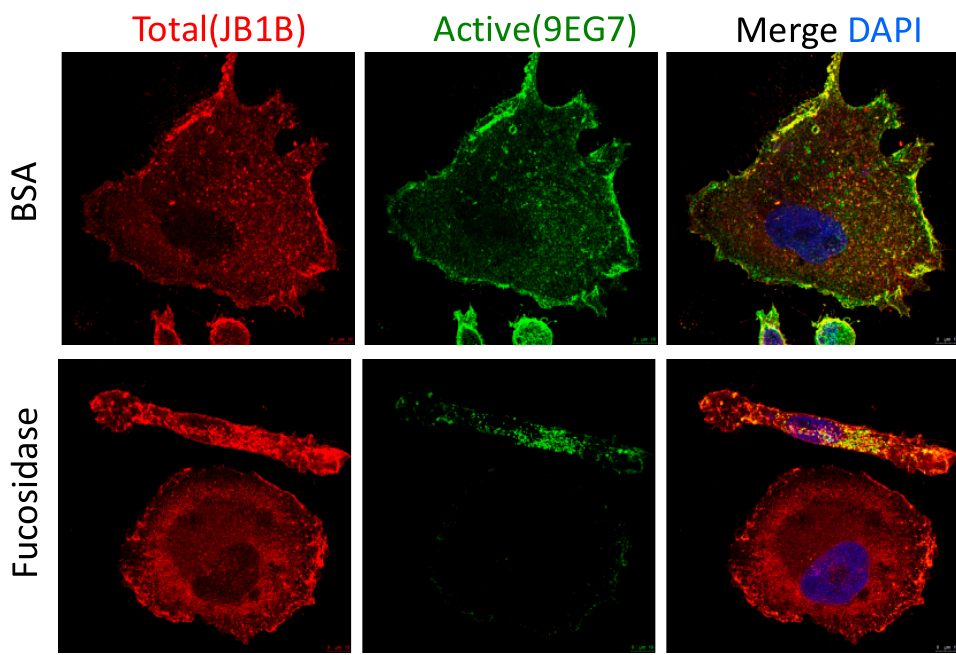
Figure 5. Fucosidase suppresses β 1-integrin activation. Confocal images of cells treated with fucosidase or BSA for 12 h. Total (red) and activated (green) β 1-integrins were shown. DAPI (blue) was used for nuclear counterstain.